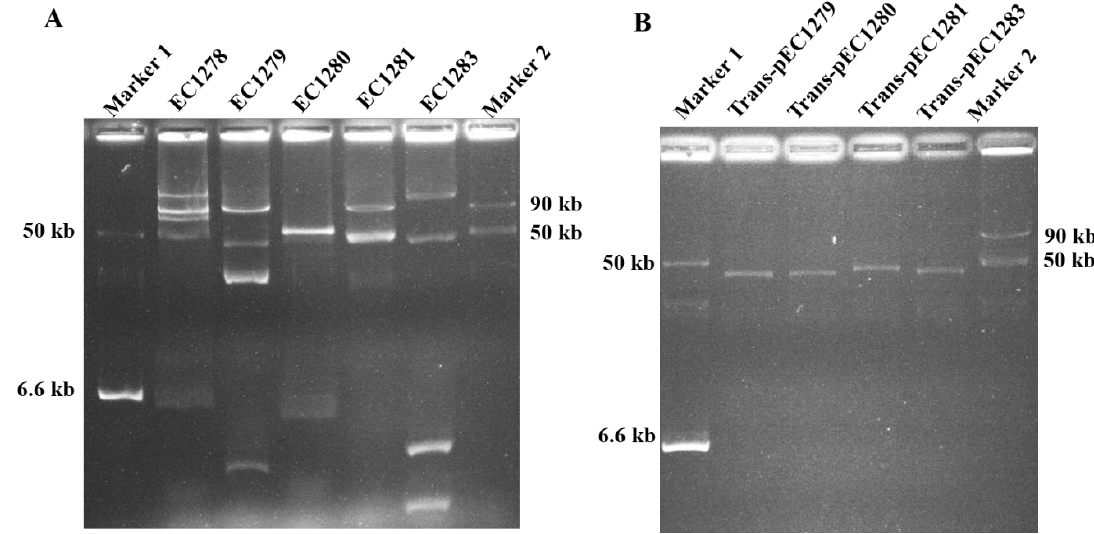
Figure 3. Plasmids in the colistin-resistant strains. ( A ) Plasmids in the riverine colistin-resistant E. coli isolates. ( B ) Plasmids in the transconjugants that obtained colistin-resistant plasmids from the riverine strains. Size markers 1 and 2 were plasmids isolated from Salmonella strains OU7058 and OUT7526, respectively [35].